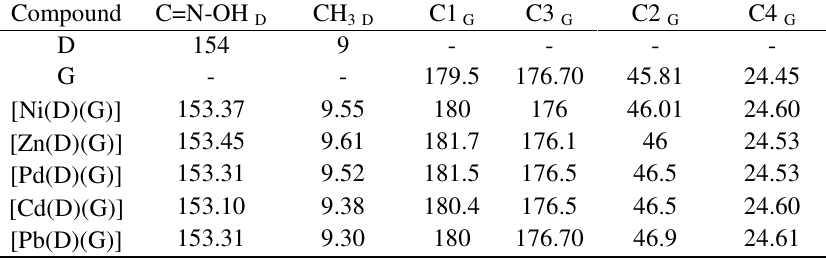
Table 4. 13 C NMR data ( δ , ppm) of the free ligands and their complexes in DMSO- d